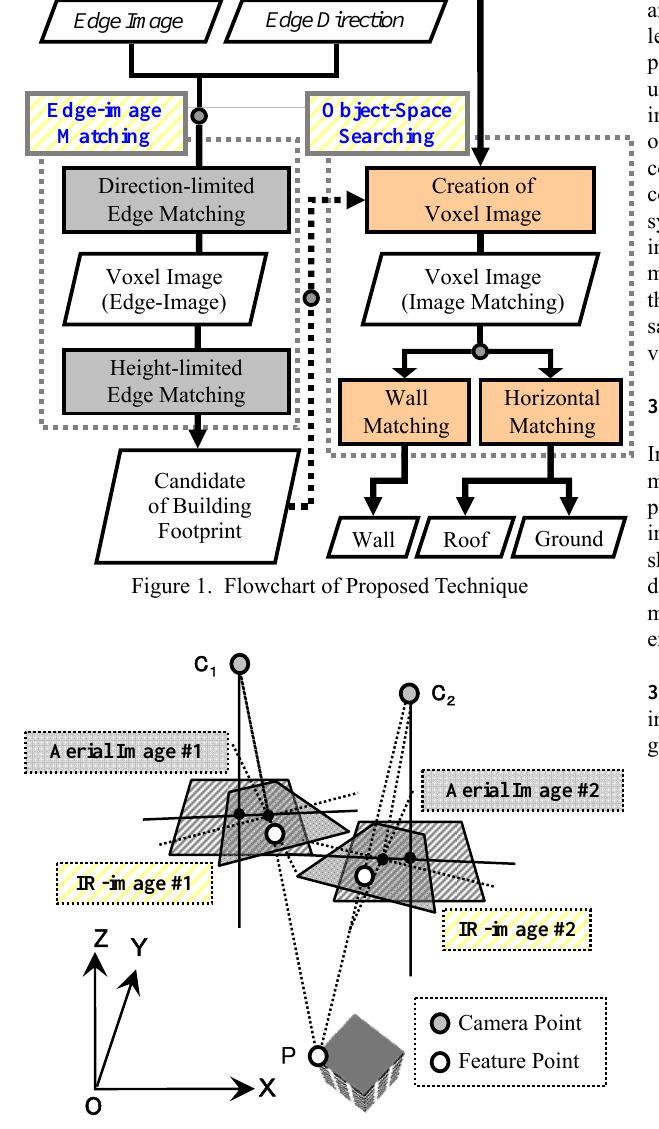
Figure 2. Independent Rectification Method